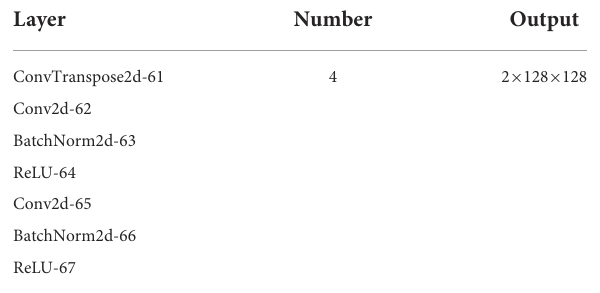
TABLE 2 Parameter of the transformer. TABLE 3 Parameter of the